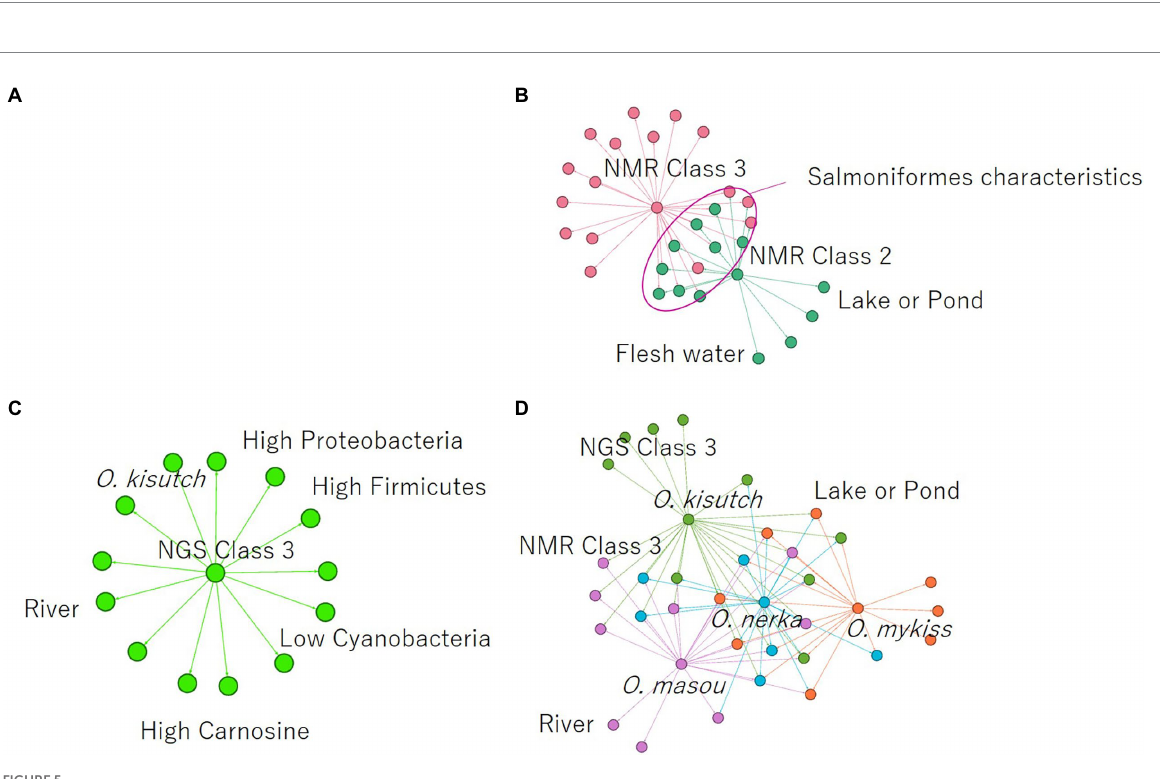
molecular groups in muscles, intestinal microbiota, and nonnumerical information. High levels of creatine and anserine, which are beneficial to humans, were observed.